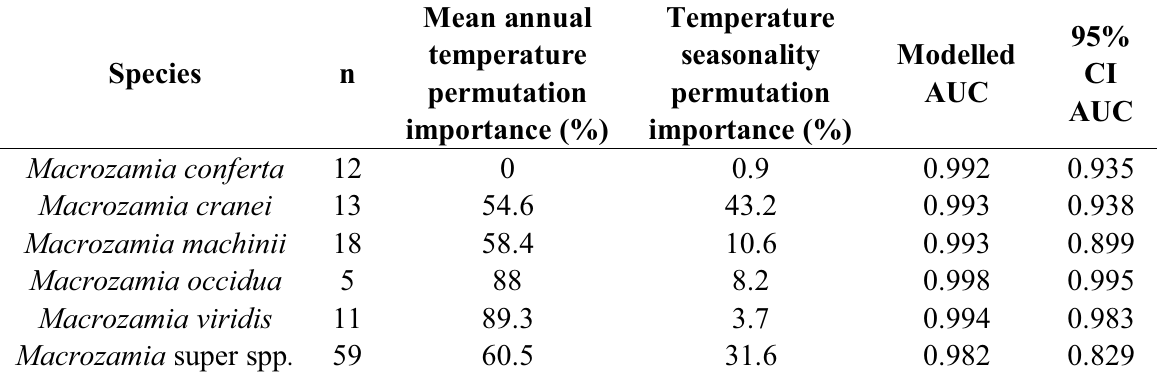
Table 1. Contribution of annual mean temperature and temperature seasonality to each Macrozamia model, model AUC value and 95% confidence interval (CI) AUC values of the randomly drawn null-models (n =